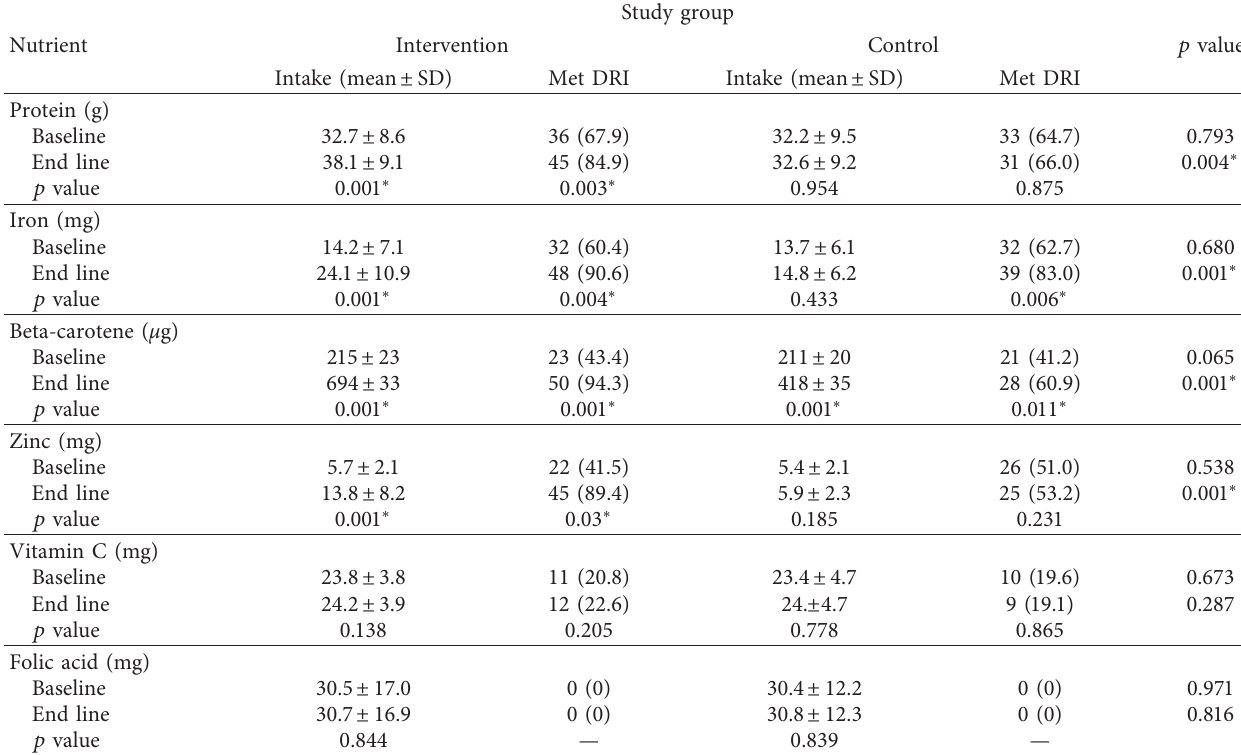
Table 4: Nutrient intake of study participants in comparison with Dietary Reference Intakes (DRIs) at baseline and end of the study.